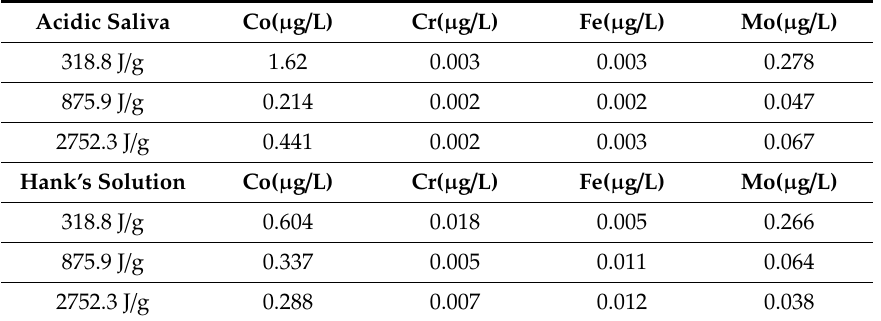
Table 4. Release amount of metal in Hank’s solution and Artificial acidic saliva after seven days.